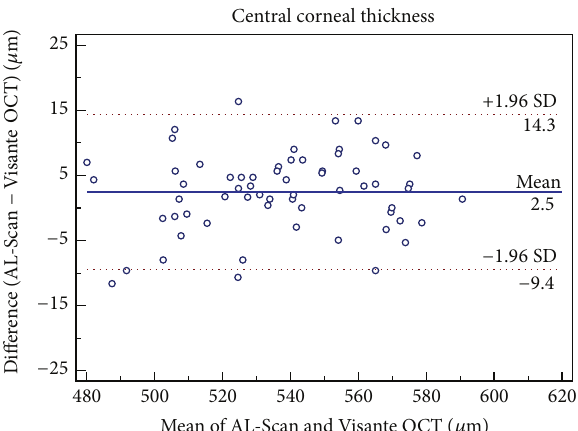
SD: standard deviation.